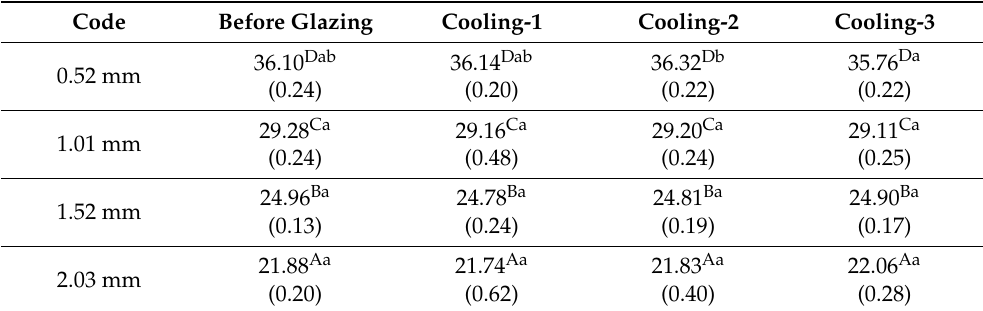
Table 4. Average transmittance (AT, %) for each group of the zirconia specimens with different thicknesses (mean ± SD).